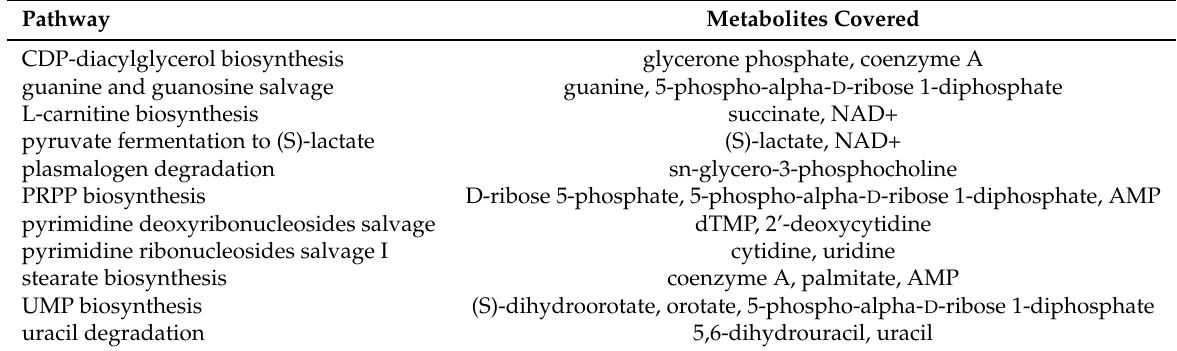
Table A12. McDonnell 2013, Pathway Covering Using Biosynthesis-Preferred Cost